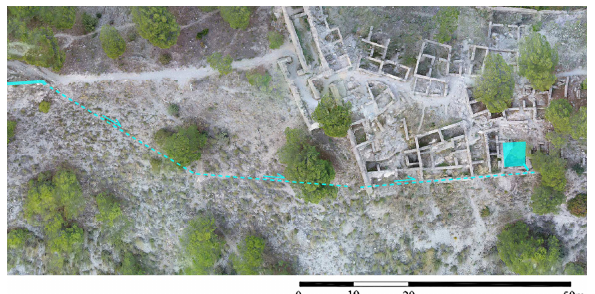
Figure 3. Orthophotograph of the fortified settlement of Los Guájares. Situation of the cistern and hypothesis of the water supply